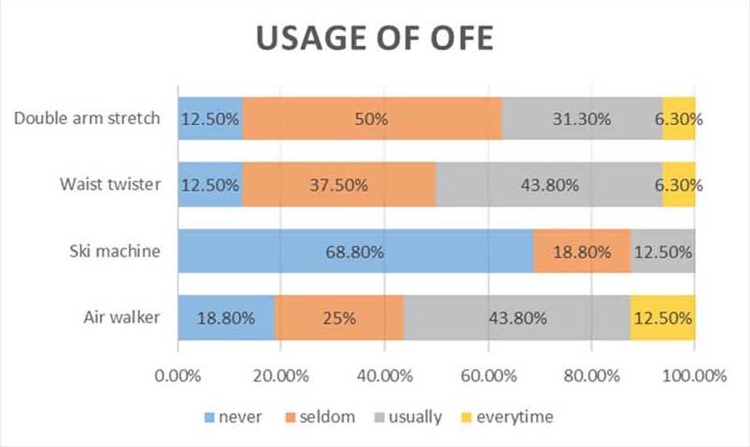
Frequency of OFE use at parks.